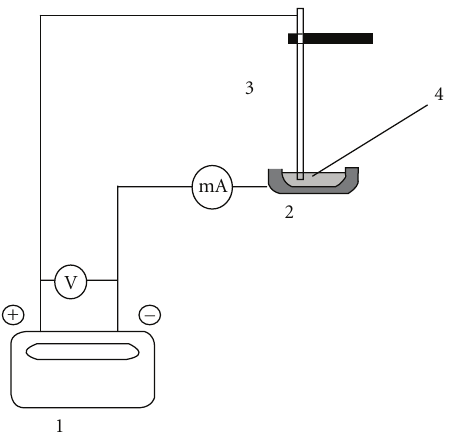
Figure 1: Schematic diagram for electrodeposition from a drop. (1) Power supply, (2) SS platform: cathode, (3) Pt wire: anode, (4) drop of modifier solution.